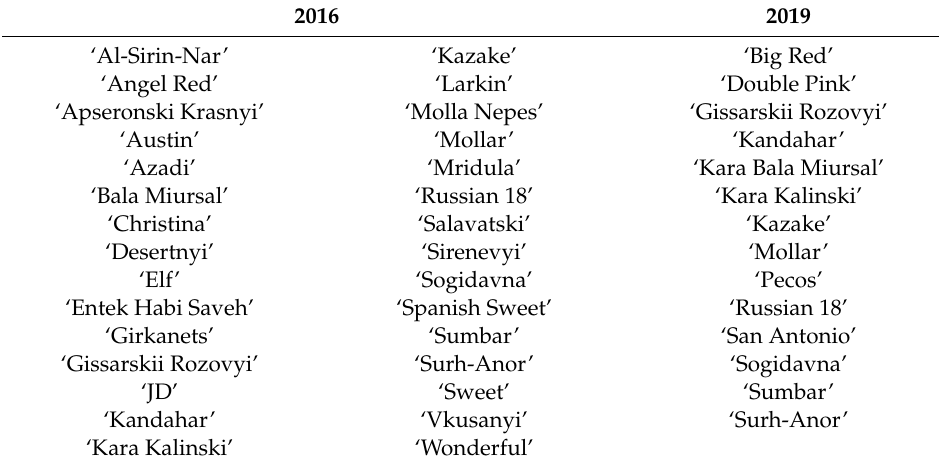
Table 1. Pomegranate ( Punica granatum ) cultivars as host candidates of Acanthococcus lagerstroemiae used in feeding trials in 2016 and 2019,